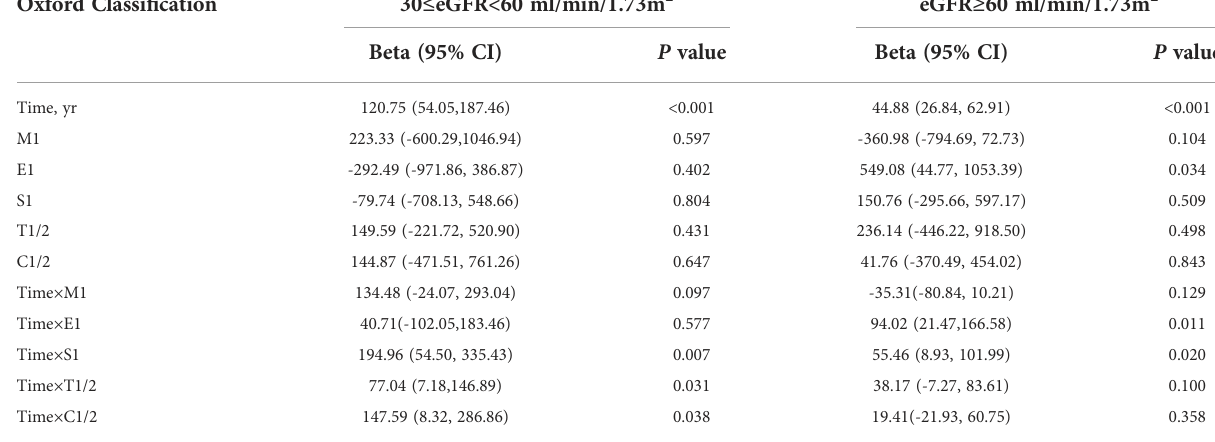
TABLE 3 Association of the Oxford Classi fi cation score MEST-C with the changes in PCR according to 30 ≤ eGFR<60 and eGFR ≥ 60 ml/ min/1.73m 2 . Oxford Classi fi